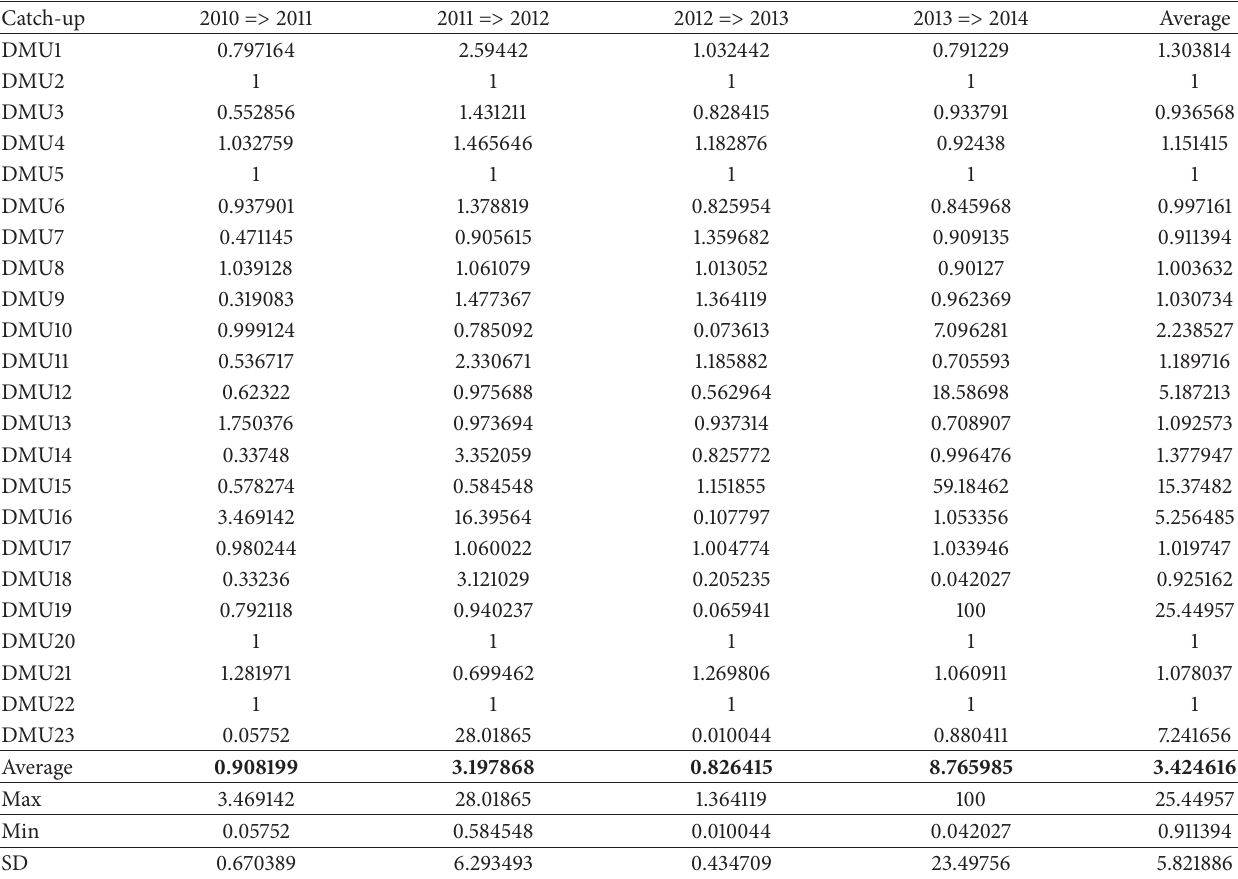
Table 13: Efficiency (catch-up) change over the period 2010 to